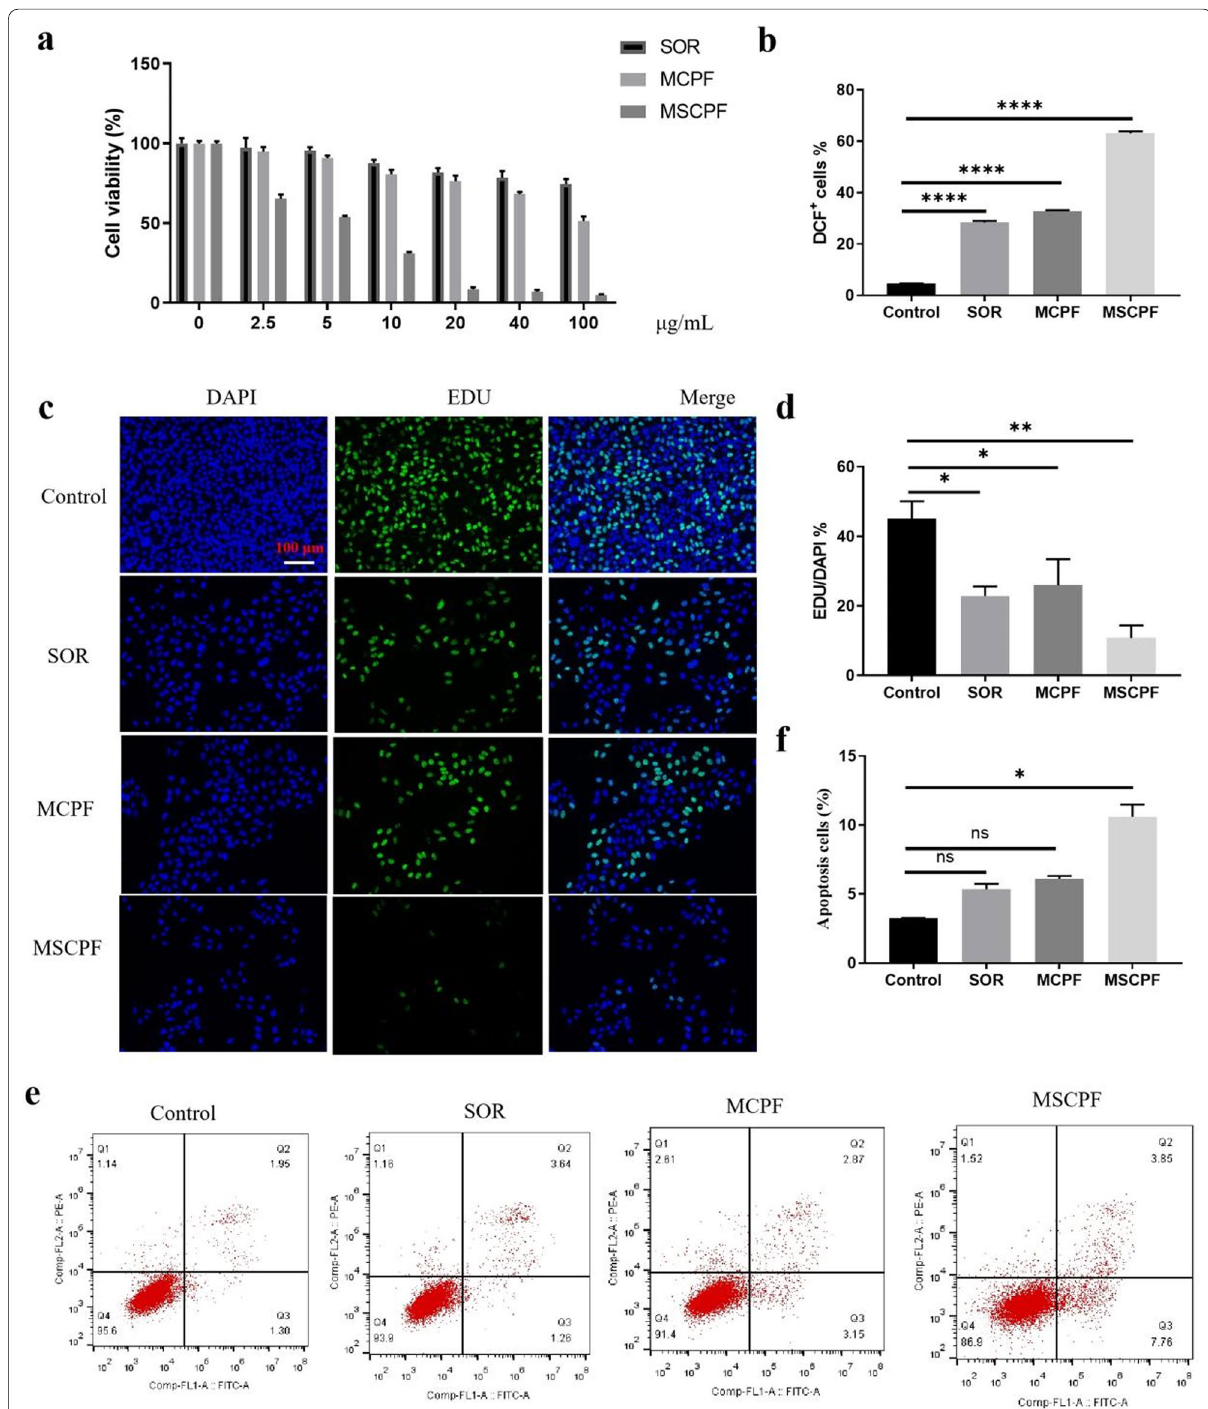
Fig. 4 a In vitro cytotoxicity of different concentrations of MSCPF NPs on SMMC-7721 cells. b ROS production of MSCPF nanoplatform within the SMMC-7721 cells upon irradiation (660 nm at 500 mW cm − 2 and 808 nm at 1.5 W cm − 2 ). c Representative images of cell proliferation by 5-ethynyl-2 ′ -deoxyuridine (EDU) assay in vitro. d The percentage of EdU-positive cells were quantified. e Apoptosis of cancer cells were analyzed by Annexin V-FITC/PI staining by SOR, MCPF, and MSCPF. f The apoptosis rates of SMMC-7721 cells were